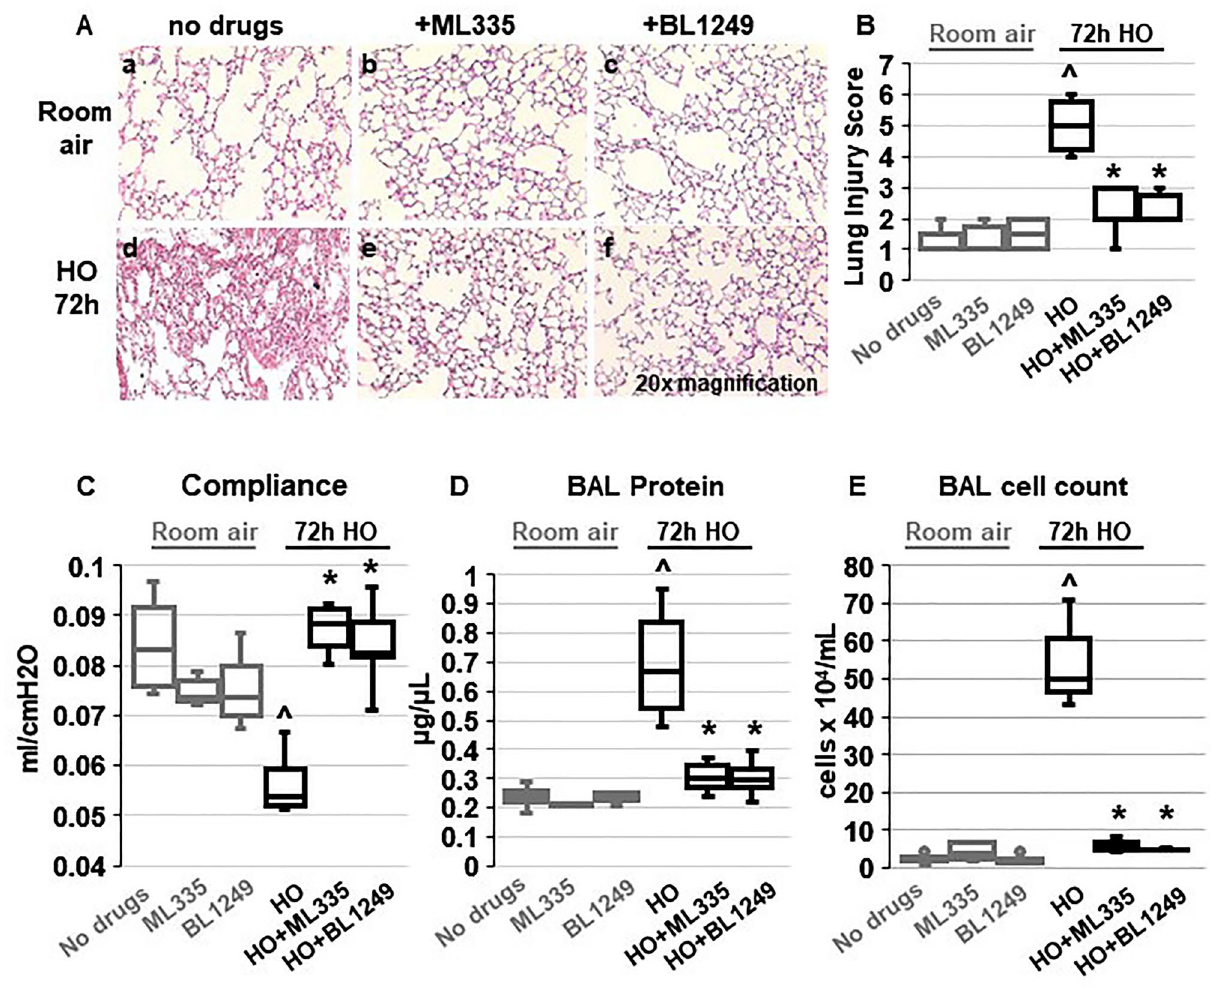
Figure 1. TREK-1 activation with the novel compounds ML335 and BL1249 protects form HO-induced lung injury: ( A ) Representative images of H&E-stained lung sections of WT mice exposed to either room air (panels a-c) or HO (panels d-f) for 72 h. All mice received once-daily, intra-tracheal ( i.t. ) injections of ML335, BL1249, or a vehicle control (no drugs) via brief endotracheal intubation. HO exposure caused significant lung injury (panel d), which was ameliorated by concomitant treatment with ML335 or BL1249 (panels e, f). ( B ) Summary of cumulative Lung Injury Scores of n = 5 independent experiments. ( C – E ) The HO-induced decrease in semi-static lung compliance, and increase in BAL fluid total protein and cell count were counteracted by ML335 and BL1249. Data are represented as Box-Whisker plots with medians, 1st and 3rd quartiles, and max and min values; n = 5–9; ^compared to mice injected with a vehicle control and exposed to room air (no drugs), *compared to HO exposed mice; p ≤